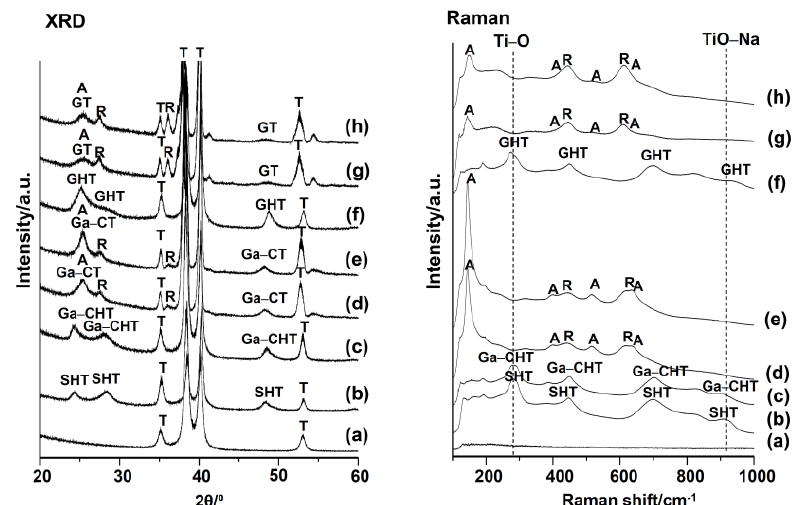
Figure 2. XRD and Raman spectra of surfaces of Ti ( a ) untreated or subjected to ( b ) NaOH treatment, and subsequent ( c ) 100Ca + 0.05Ga and ( d ) heat treatment, and finally ( e ) water treatment, or ( f ) 100Ga after the NaOH treatment, and subsequent ( g ) heat and finally ( h ) water treatment. T: α-Ti A: Anatase R: Rutile SHT: Na x H 2 − x Ti 3 O 7 Ga–CHT: Ga x Ca y H 2-(3 x +2 y ) Ti 3 O 7 GHT: Ga x H 2 − 3 x Ti 3 O 7 . Ga–CT: